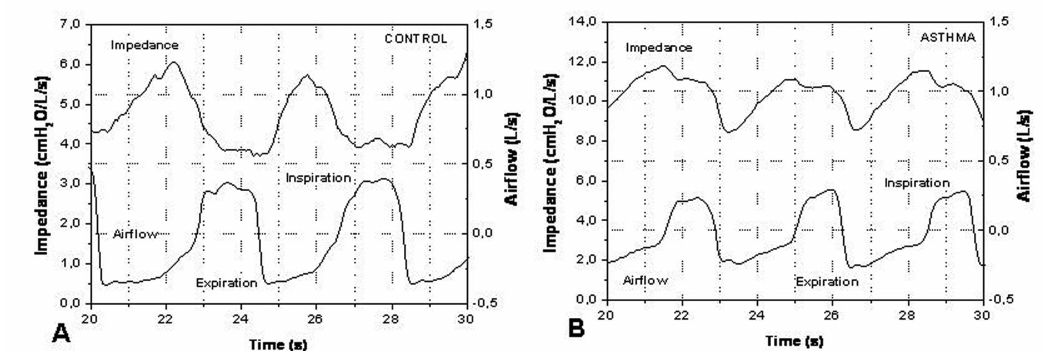
Figure 1 - Typical airflow and respiratory impedance analyzed in the control group (A) and asthmatic (B) individuals. Notice the difference in the imped- ance scales.